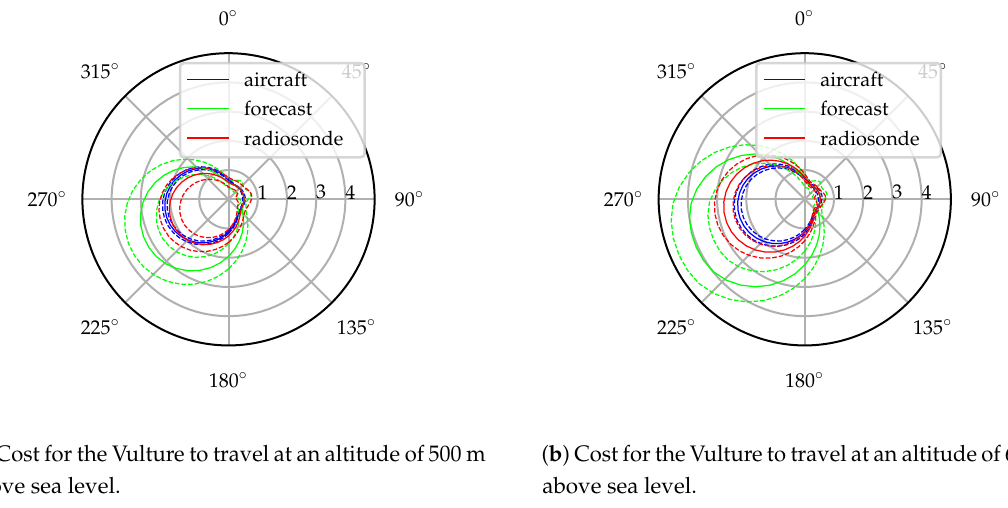
Figure 23. Cost for the Vulture to travel in any direction at an average groundspeed of 15 m s − 1 . Cost is expressed in specific power and evaluated at 08:00 local time